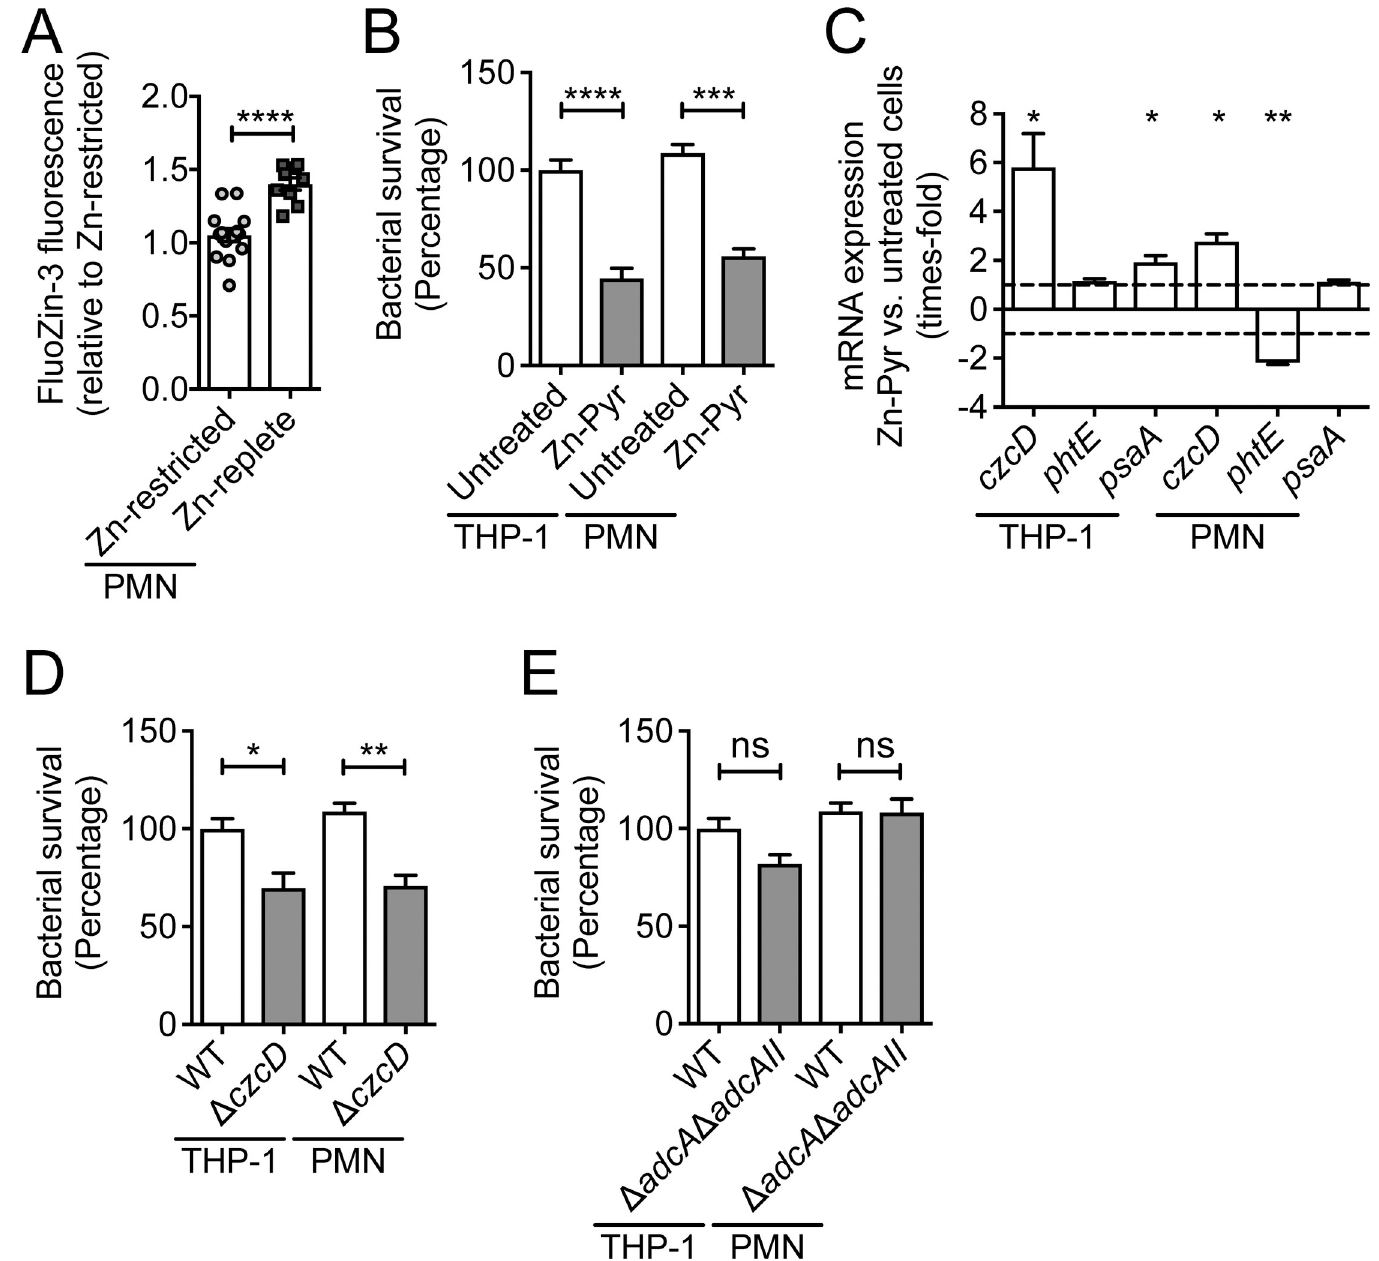
Fig 5. The role of Zn in phagocyte-mediated killing of S . pneumoniae . (A) Intracellular Zn in PMNs from Zn-restricted or Zn-replete mice examined using FluoZin-3 AM and flow-cytometry (n � 5). Relative fluorescence was corrected to levels observed in the phagocytic cells in Zn-restricted mice. Data represent the mean ( ± S.E.M.) of two independent experiments with statistical analyses performed by Student’s t -test. (B) Survival of wild-type S . pneumoniae D39 in THP-1 monocyte-derived macrophages (n = 5) and human PMNs (n = 3) in the presence of Zn [50 μ M Zn-pyrithione (Zn-pyr)] supplementation, by comparison with unsupplemented phagocytic cells. Data represent the mean ( ± S.E.M.) of three independent experiments with statistical analyses performed by Student’s t -test. (C) Expression levels of czcD , phtE and psaA in S . pneumoniae in THP-1 monocyte-derived macrophages (n = 5) and human PMNs (n = 3) with or without 50 μ M Zn treatment. Expression levels represent the fold-change difference between pneumococci in the Zn-supplemented phagocytic cells compared to untreated cells. Data represent the mean ( ± S.E.M.) of three independent experiments with statistical analyses performed by Student’s t -test. Survival of S . pneumoniae mutant strains defective in Zn efflux ( Δ czcD ) (D) or Zn uptake ( Δ adcA Δ adcAII ) (E) in THP-1 monocyte-derived macrophages (n = 5) and human PMNs (n = 3), compared to the wild-type strain. Data represent the mean ( ± S.E.M.) of three independent experiments with statistical analyses performed by Student’s t